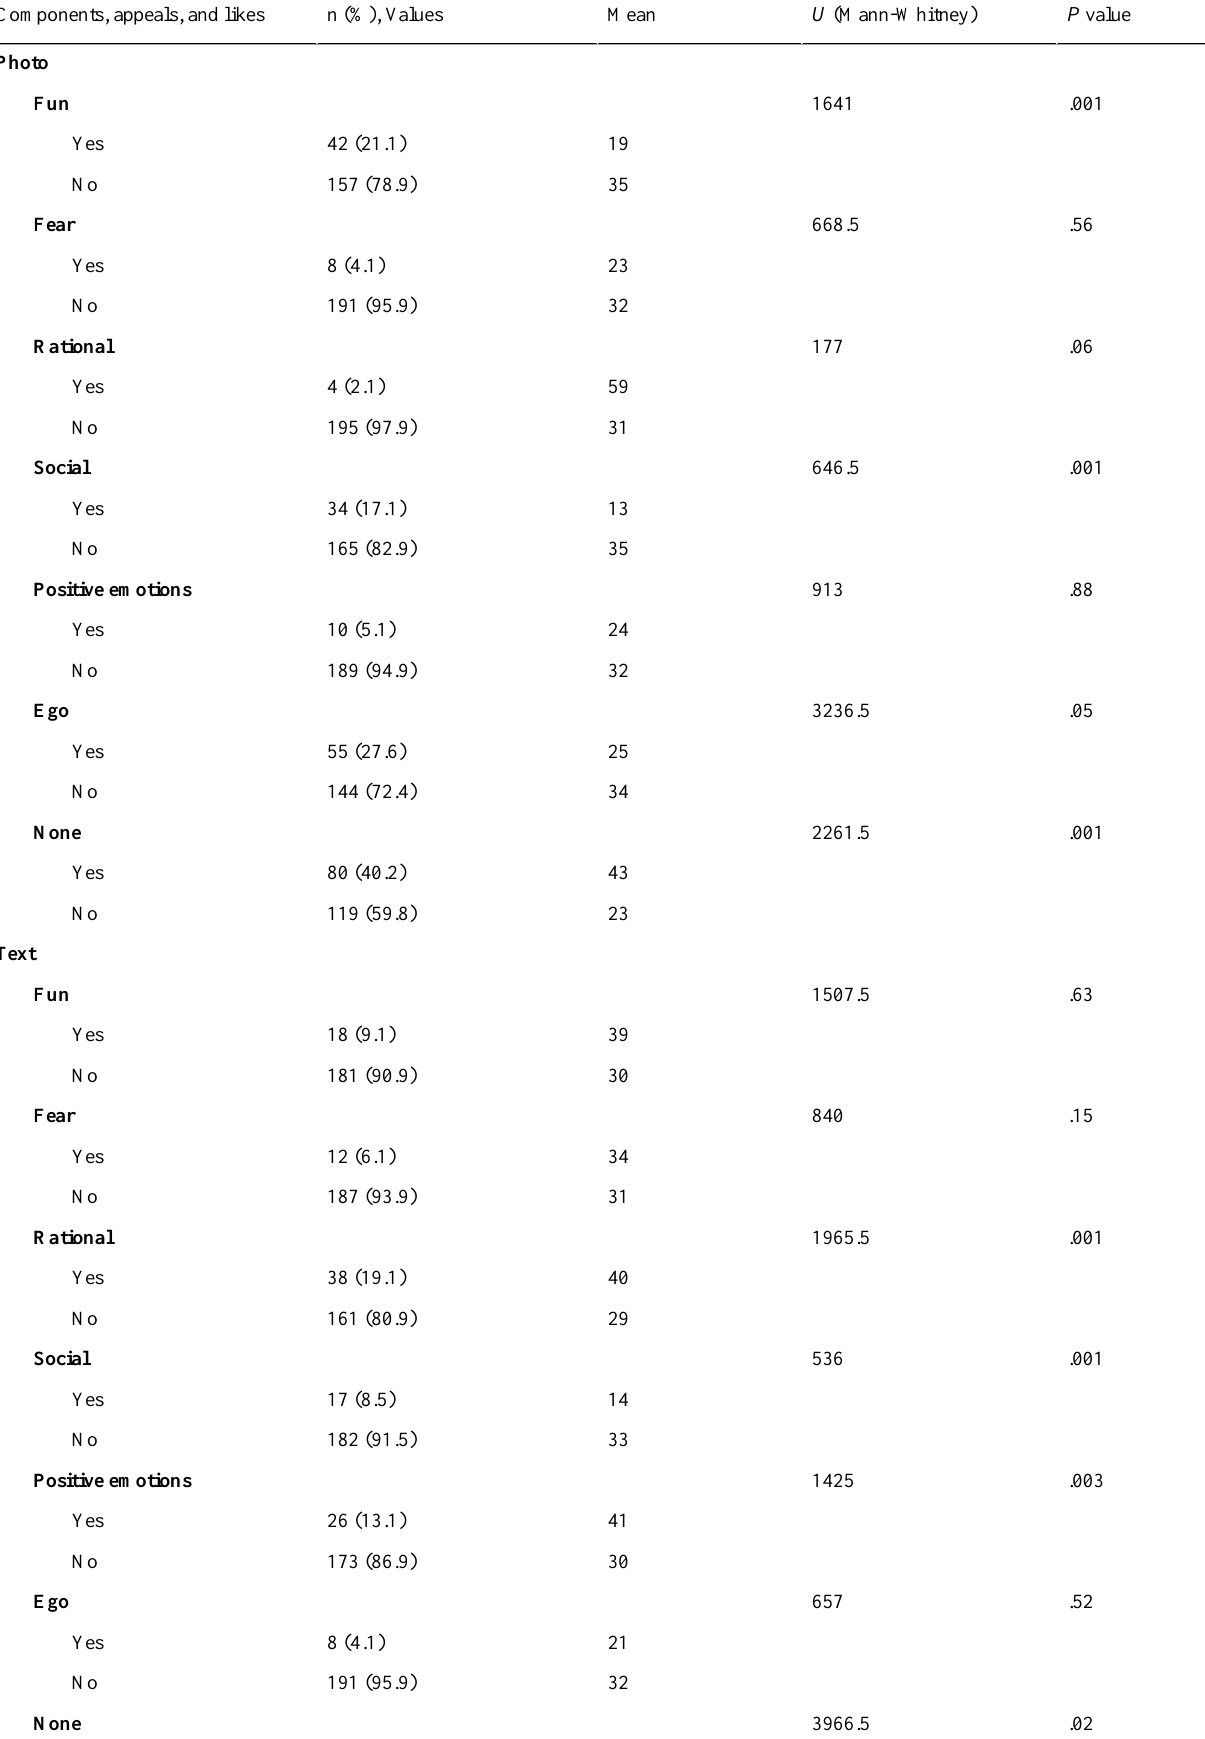
Table 1. Association between the number of likes and appeals in different components of the Instagram posts